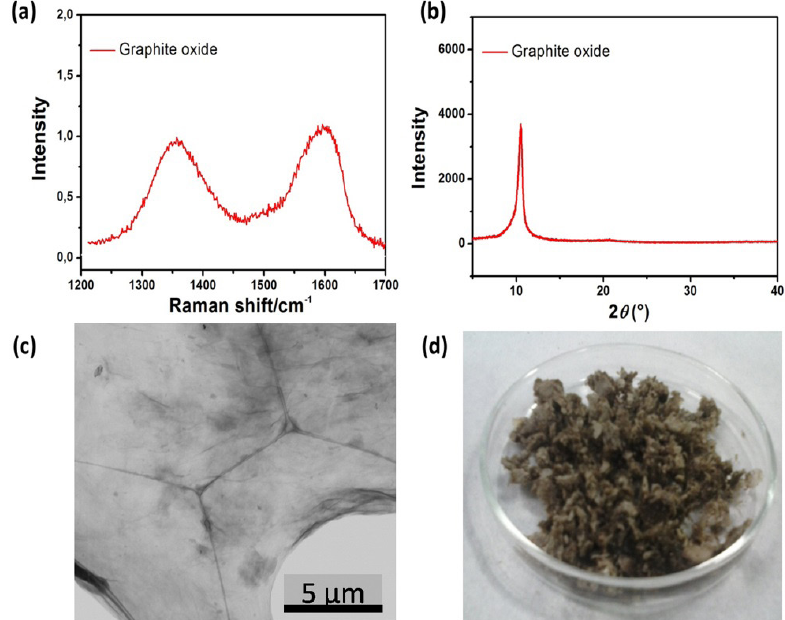
Figure 1. Graphite oxide structural and morphological characterization. Raman (a), XRD patten (b), TSEM image (c) and picture of the freeze-dried graphite oxide